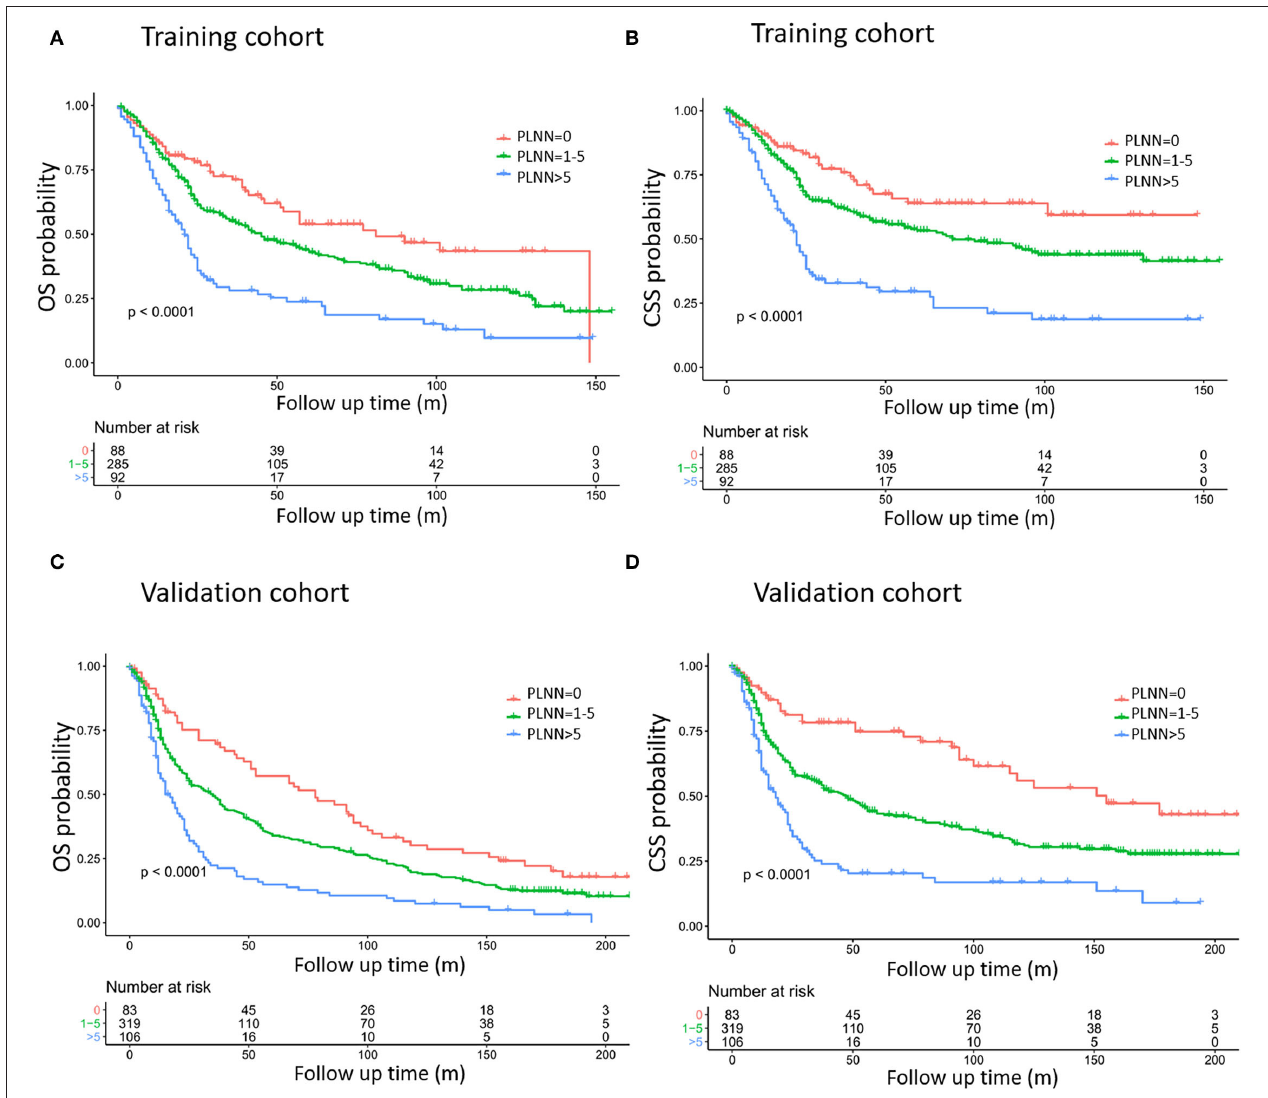
FIGURE 2 | Kaplan–Meier curves estimating overall survival (OS) (A,C) and cause-specific survival (CSS) (B,D) based on training cohort (A,B) and validation cohort (C,D) definition of training cohort and validation cohort referred to Table 1 . The exact data of survival rates are referred to in Table 2 . combinations of PLNNs, cancer stages, and T, N,